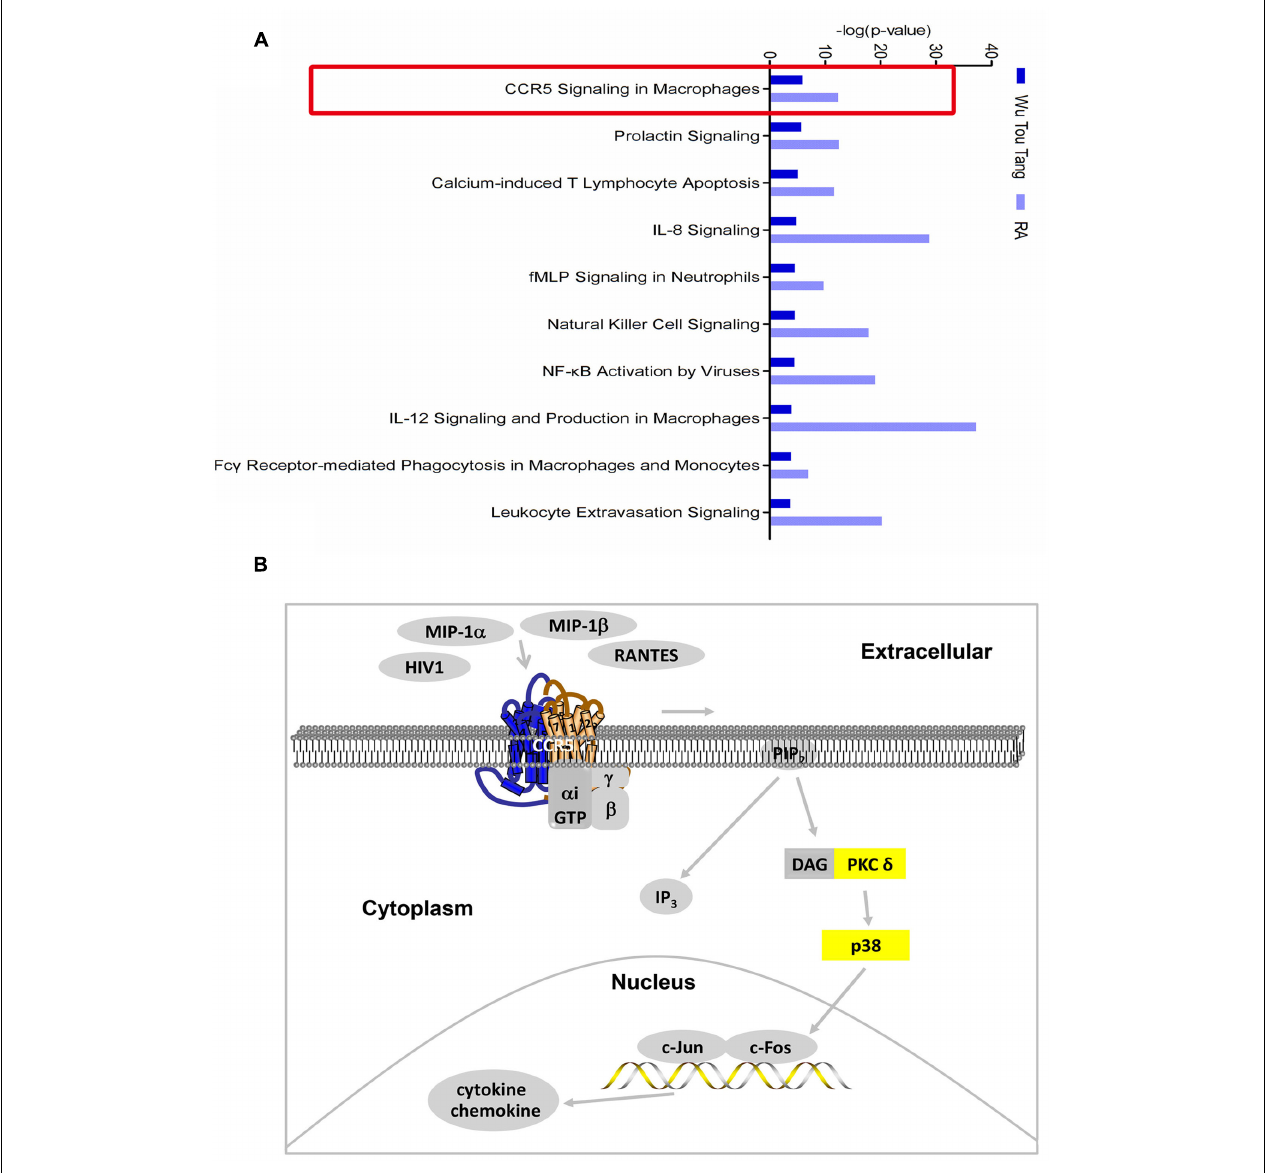
FIGURE 1 | Shared signaling pathways of WTD and RA. (A) Top 10 shared signaling pathways of Wu-Tou decoction (WTD) and RA associated with cell immune response and cytokine signaling. Top 1 signaling pathway (red rectangle marked) was the one we focused on. (B) CCR5 signaling pathway in macrophages. Molecules in yellow were targets of WTD in